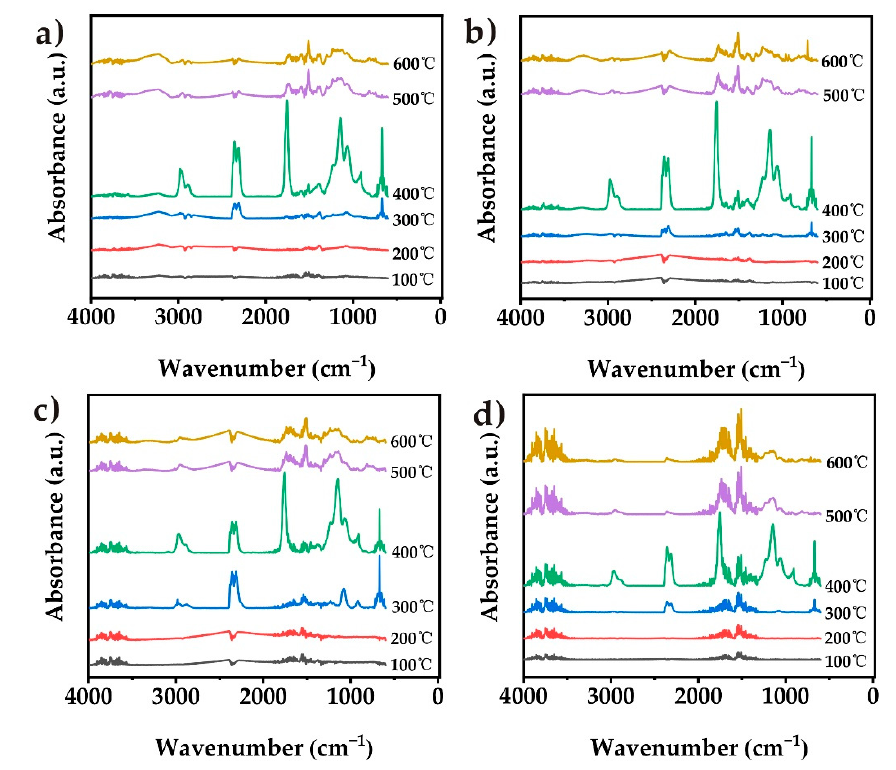
Figure 9. IR spectra of pyrolysis products for the samples at different stages of decomposition: ( a ) pure TPU, ( b ) CN-TPU, ( c ) PCN-TPU, and ( d ) Co@PCN-TPU.